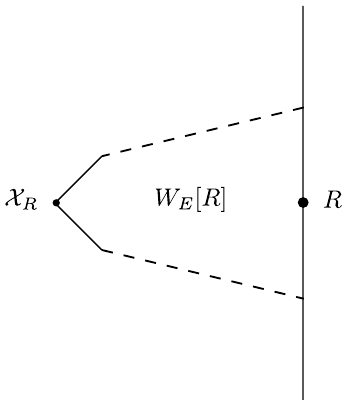
Figure 1 . The quantum extremal surface X R for boundary subregion R with associated entangle- ment wedge W E [ R ]. The dashed lines are spacelike as a result of caustics, which occur